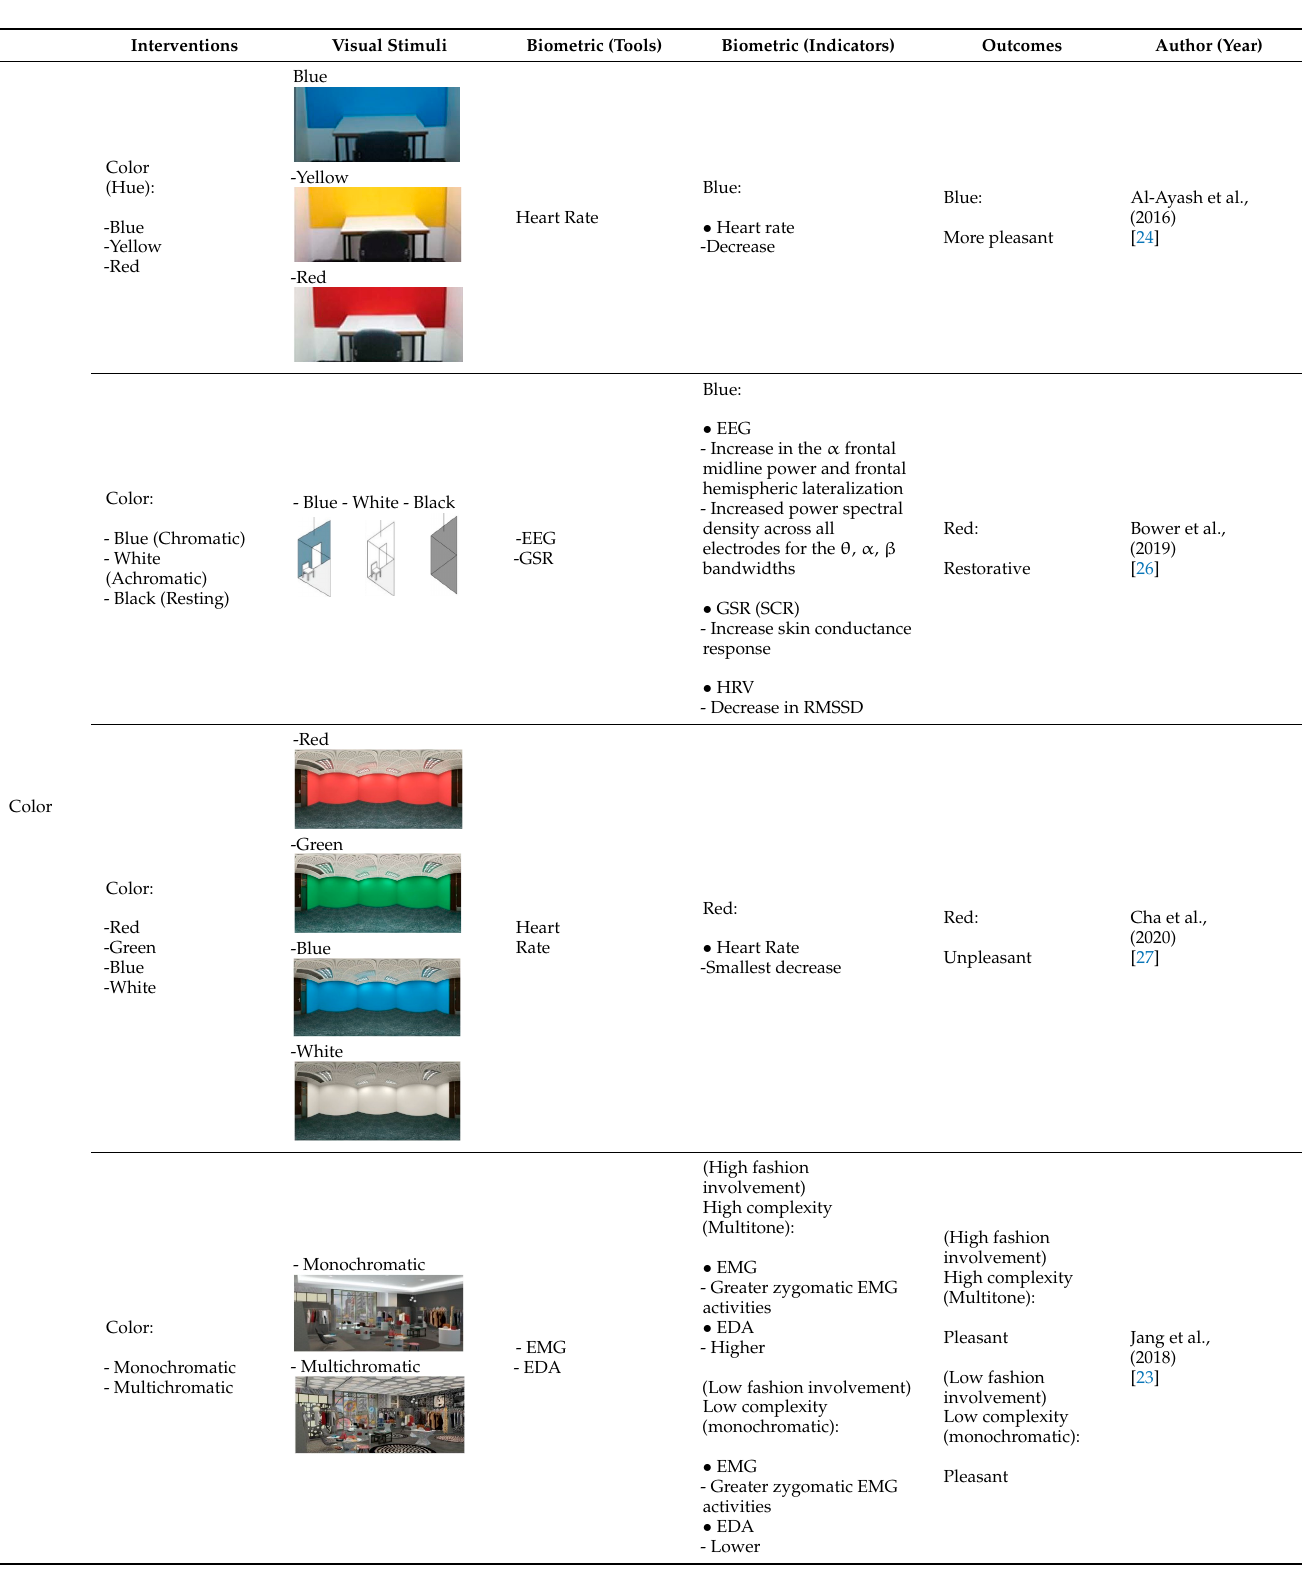
Blue: More pleasant